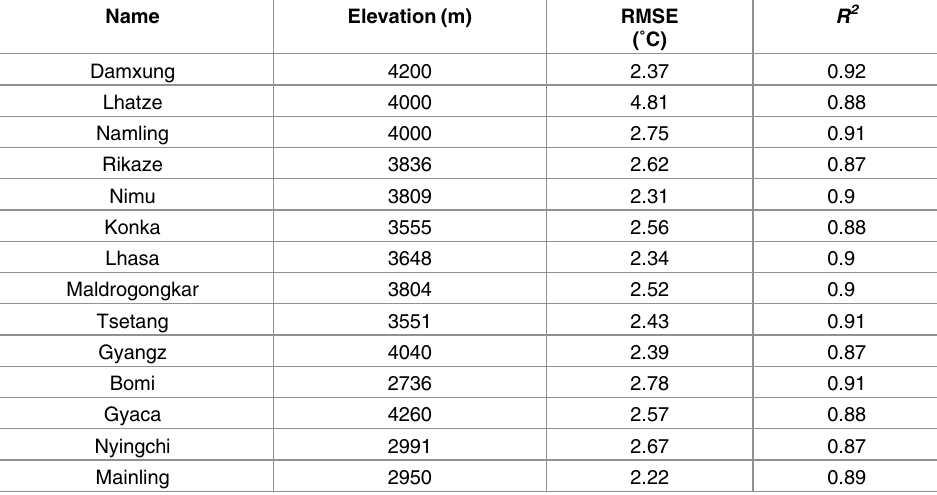
Table 2. Validation of downscaled GLDAS daily averagetemperatures at 14 stations.